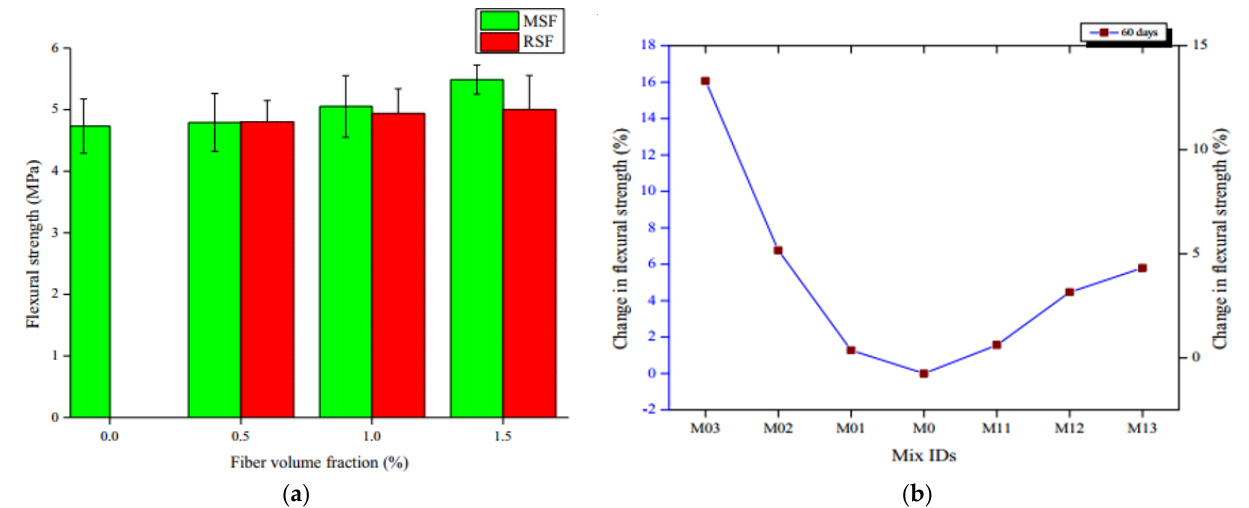
Figure 8. ( a ) FS of composites at 60 days of age [124]; ( b ) percentage variation in FS at 60 days of age [124]. The mixes M0, M01, M02 and M03 represent self-consolidating concretes with MSF contents of 0, 0.5, 1.0 and 1.5 %, respectively. The mixes M11, M12 and M13 represent self-consolidating concrete with WRSF contents of 0.5, 1.0 and 1.5 %, respectively.